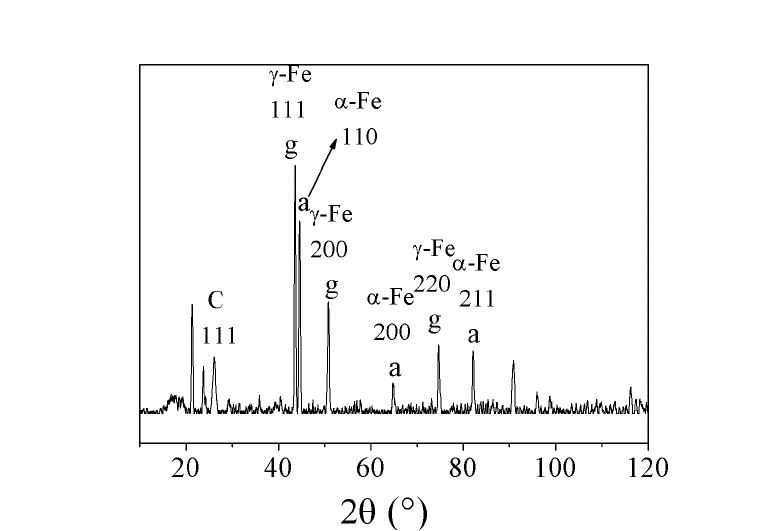
Figure 17. X-Ray diffraction spectra of Fe-CNT. The α -Fe and γ -Fe are found [12].